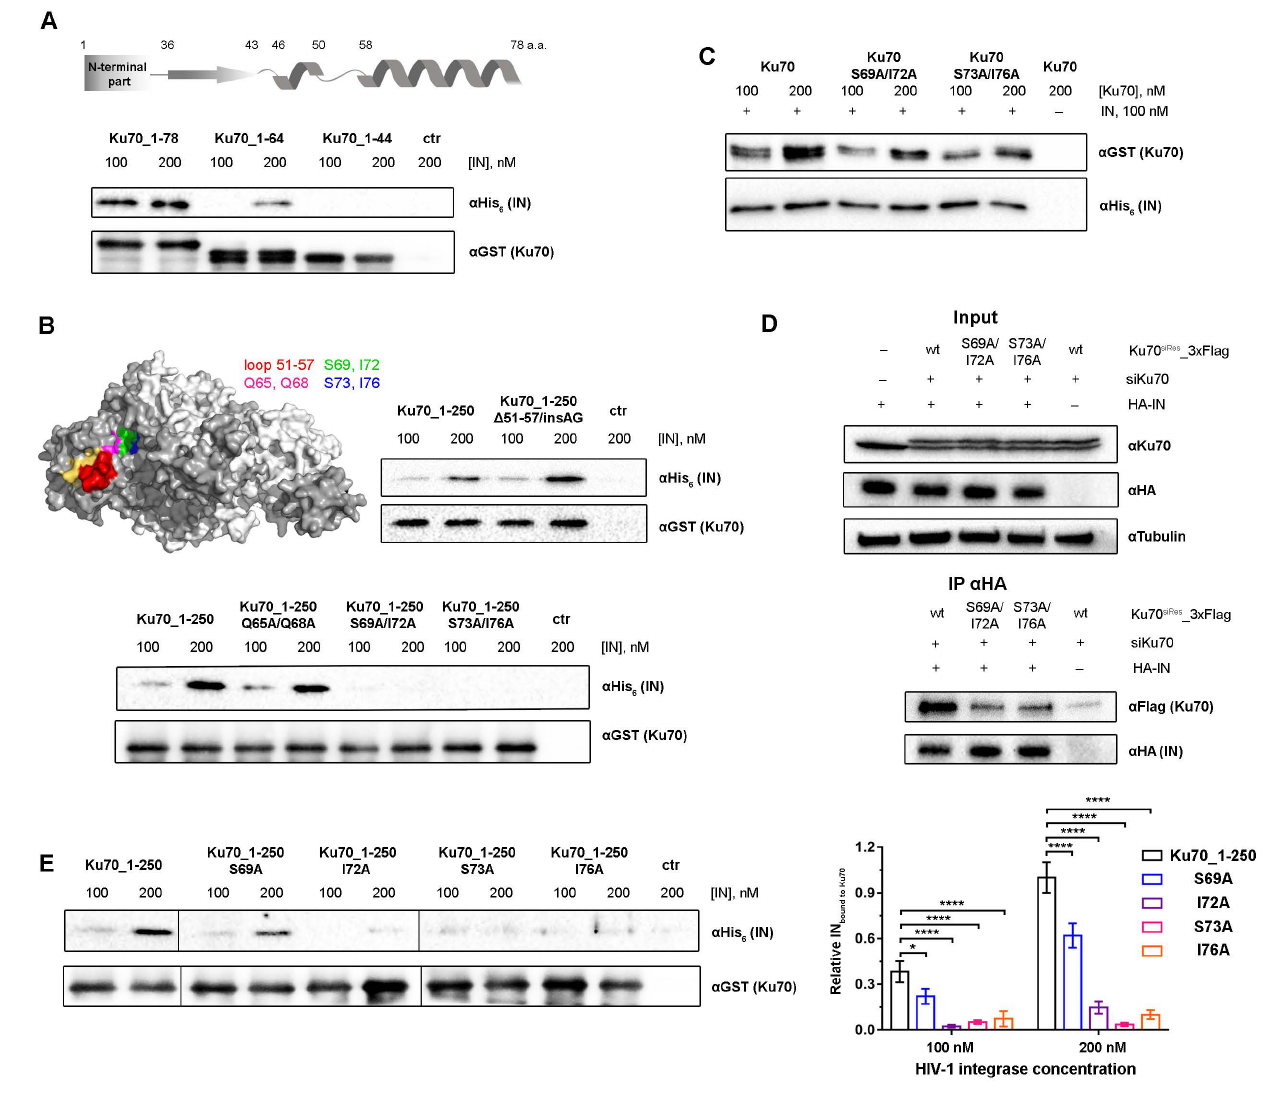
Figure 2. Identification of Ku70 residues involved in the HIV-1 IN binding. ( A ) Schematic representa- tion of the Ku70_1–78 mutant secondary structure (top), and GST-pull down analysis of the interaction between truncated Ku70 mutants and HIV-1 IN (bottom). ( B ) GST-pull down analysis of the interac- tion between HIV-1 IN and Ku70 mutants: Ku70_1–250_ ∆ 51–57/insAG, Ku70_1–250-Q65A/Q68A, Ku70_1–250_S69A/I72A, and Ku70_1–250_S73A/I76A. Top left insert depicts the position of Ku70 residues selected for mutagenesis in the structure of Ku70 (dark gray)/Ku80 (light gray) heterodimer (PDB ID: 1 JEQ). ( C ) His 6 pull-down analysis of the interaction between full-length Ku70 or its double mutants and HIV-1 IN. Quantitative analysis of WB presented at Figure S1. ( D ) Immunoprecipitation of the HA-tagged IN with 3xFLAG-tagged Ku70_wt, Ku70_S69A/I72A, or Ku70_S73A/I76A in HEK293T cells. Eluates were analyzed by Western blot (bottom panel) with anti-FLAG antibodies to detect Ku70_3FLAG and anti-HA antibodies to detect HIV-1 IN. Ten percent of the cell lysates were used for input analysis by Western blot (top panel) with anti-Ku70 antibodies for the detection of Ku70 (Ku70_3xFLAG migrates slightly slower than endogenous Ku70), and anti-HA to detect HA-IN; anti-tubulin detection was used as loading control. ( E ) GST pull-down analysis of the in- teraction between Ku70_1–250 point mutants and HIV-1 IN by Western blot (left) and quantitative analysis (right). Mean values ± SD of three independent experiments are presented. Significance was determined by two-way ANOVA, * = adjusted p -value < 0.05, **** = adjusted p -value <